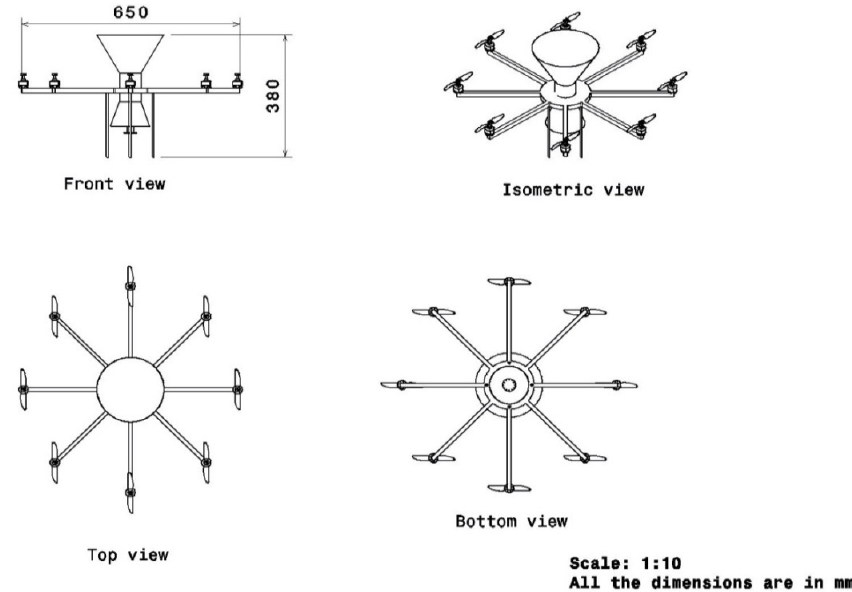
Figure 5. Conceptual design of an octocopter for environmental applications.